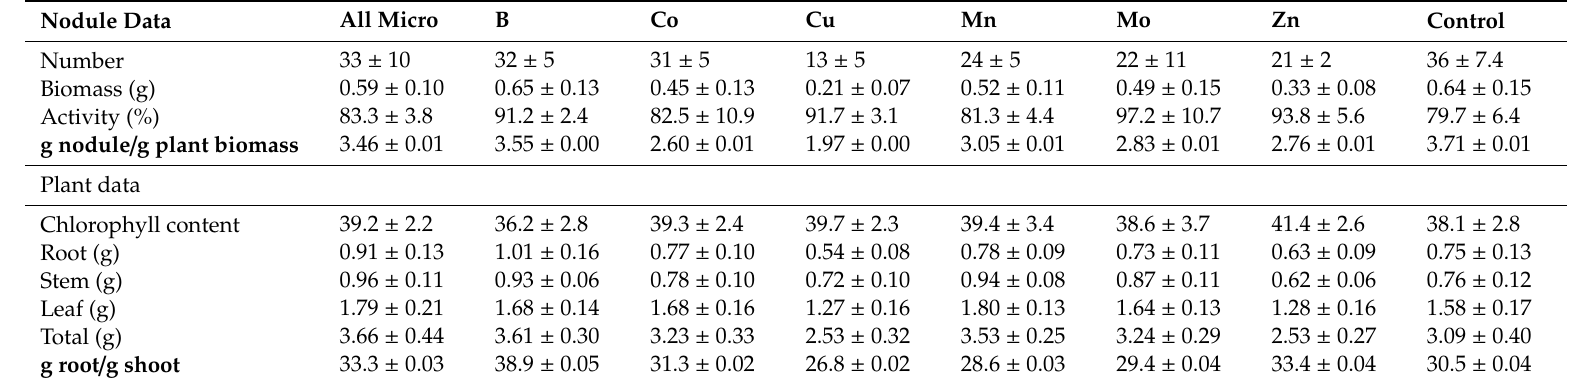
Table A4. Complete Results from Micronutrient